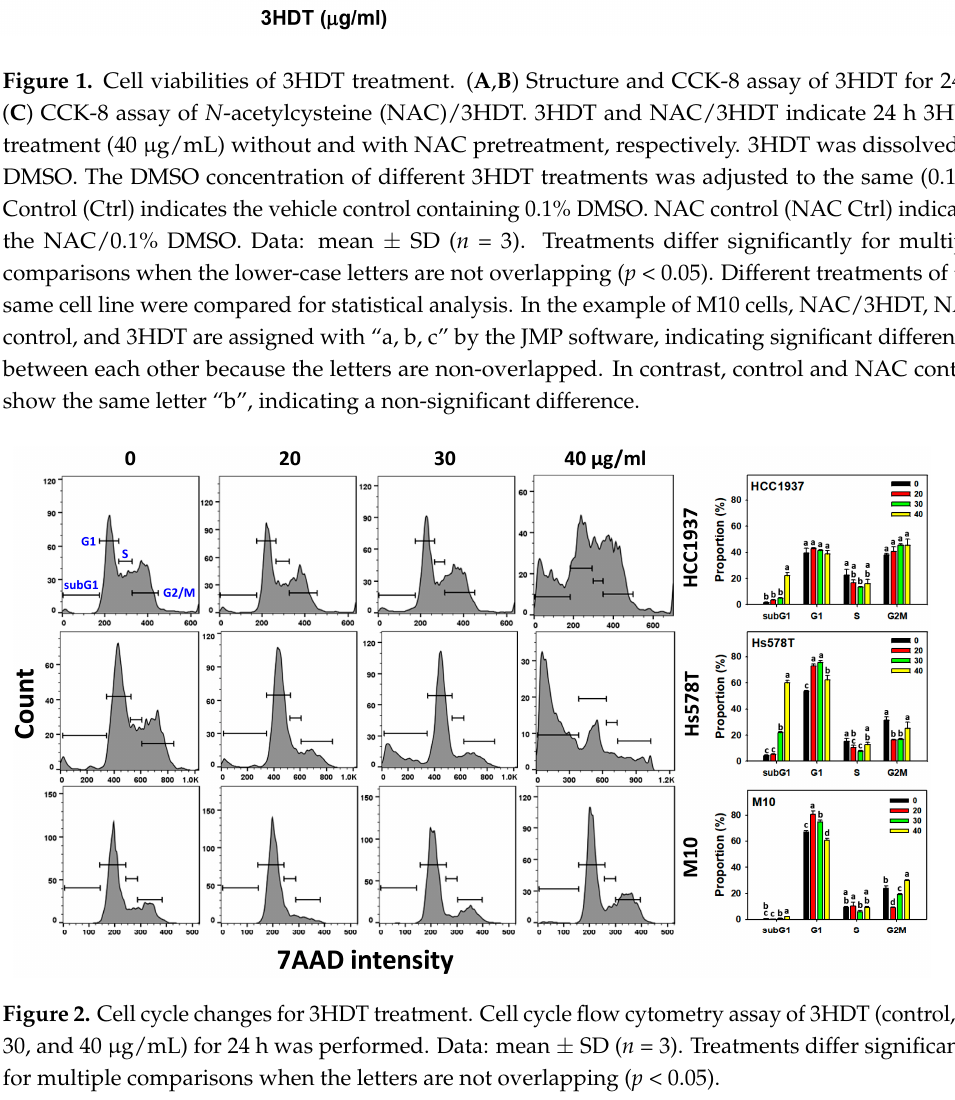
Figure 1. Cell viabilities of 3HDT treatment. ( A , B ) Structure and CCK-8 assay of 3HDT for 24 h. ( C ) CCK-8 assay of N -acetylcysteine (NAC)/3HDT. 3HDT and NAC/3HDT indicate 24 h 3HDT treat- ment (40 μ g/mL) without and with NAC pretreatment, respectively. 3HDT was dissolved in DMSO. The DMSO concentration of different 3HDT treatments was adjusted to the same (0.1%). Control (Ctrl) indicates the vehicle control containing 0.1% DMSO. NAC control (NAC Ctrl) indicates the NAC/0.1% DMSO. Data: mean ± SD ( n = 3). Treatments differ significantly for multiple comparisons